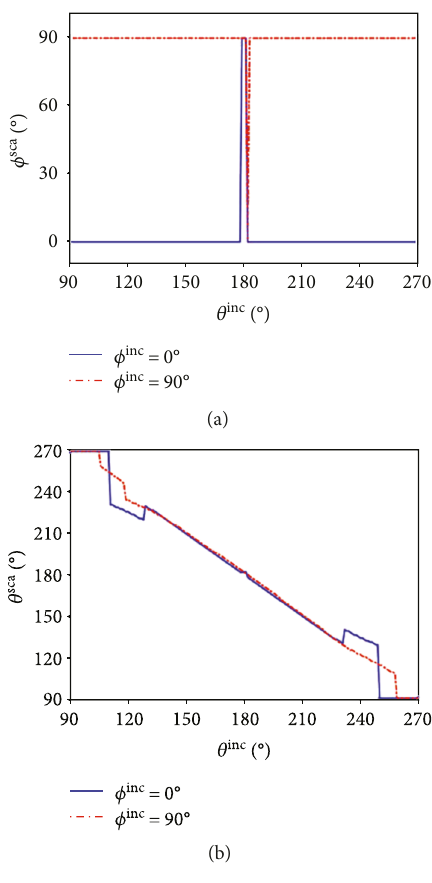
Figure 9: Direction of the maximum RCS ( α = 90 ).